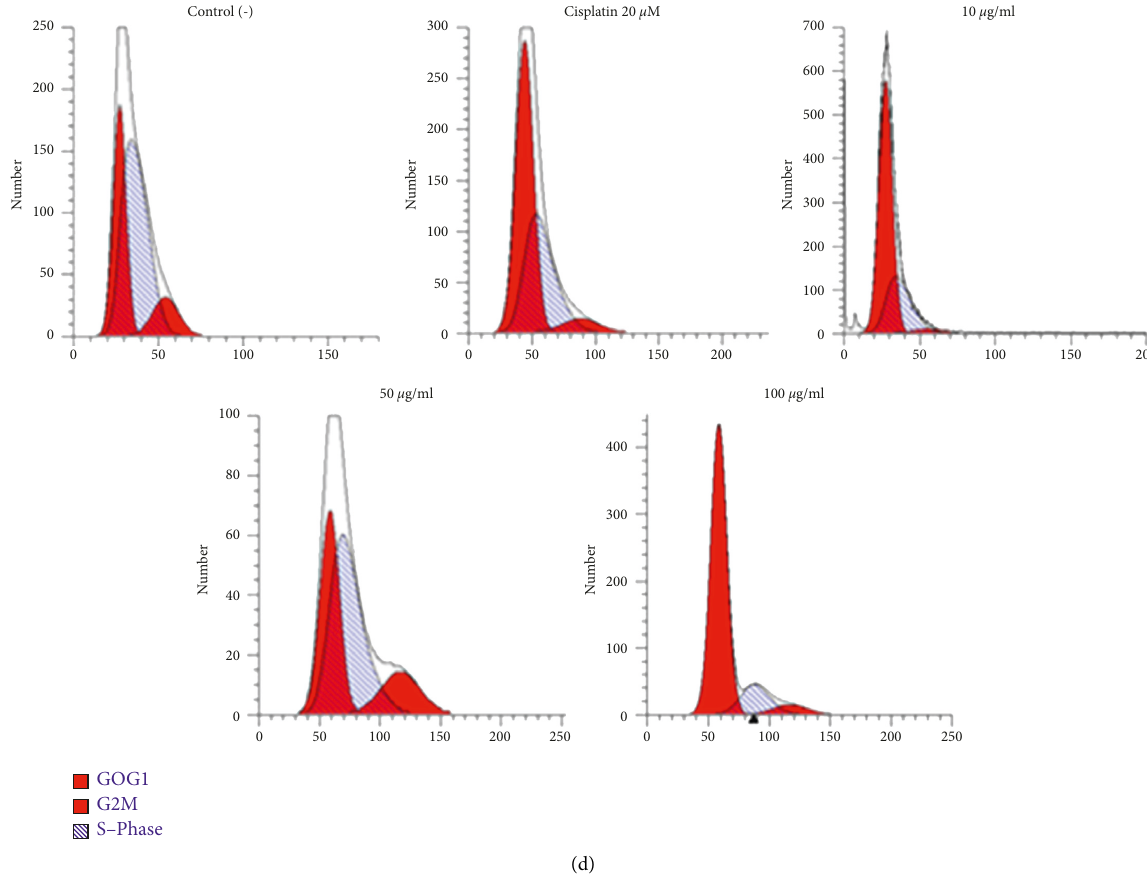
Figure 8: PME induces cell cycle arrest and regulates the expression of genes in CAL-27 spheroids. (a) P53 and HIF1-alpha mRNA expression in CAL 27 spheroids PME-treated (10, 50, and 100 μ g/ml) compared to the untreated control and 20 μ M cisplatin (b) MMP9 and CDH1 mRNA expression in CAL 27 spheroids. (c) The percentage of cells in G0/G1, G2/M, and S cell cycle phases analysis of CAL 27- spheroids following treatment for 72h by flow cytometry. (d) Representative histogram of flow cytometry cell cycle. The results shown are representative of three independent experiments. ∗∗ p < 0.05 and ∗∗∗ p < 0.005, control versus PME-treated